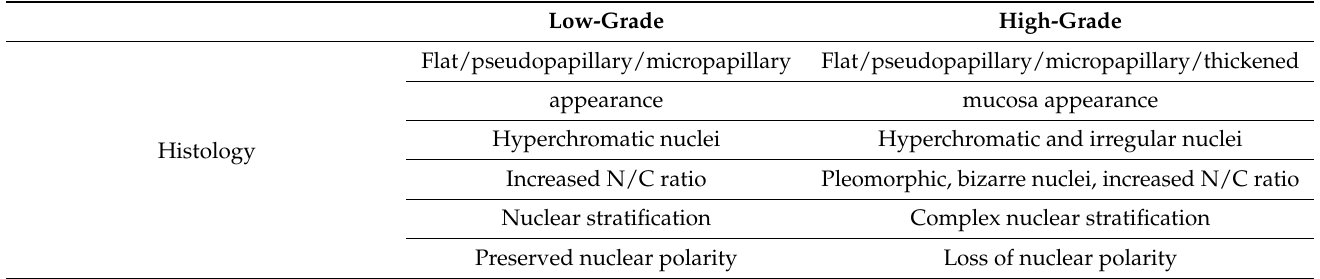
Table 3. Differences between low-grade and high-grade BilIN (biliary intraepithelial neoplasm). Low-Grade High-Grade